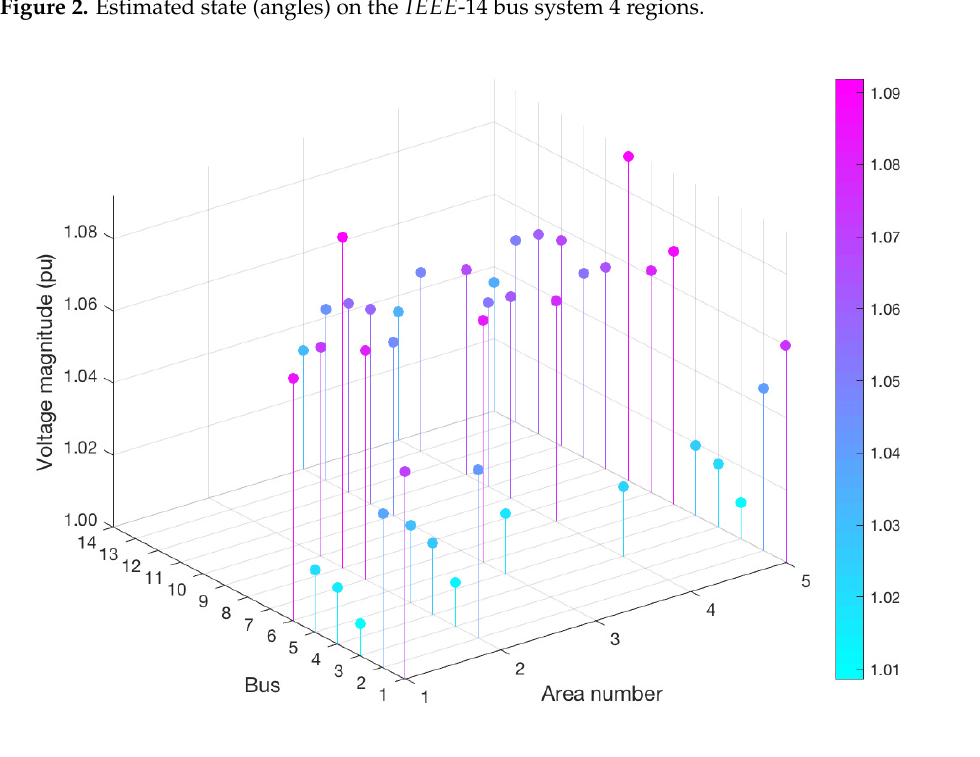
Figure 3. Estimated state (magnitude) on the IEEE -14 bus system 4 regions. To show the performance of the presented model, the error metric e k = in log scale is utilized. A 100 Monte Carlo simulation is generated and the average error curves for each area is shown in Figure 4. From the results, one can see that the presented model is able to achieve a per area mean error smaller than 10 − 2 within a few more